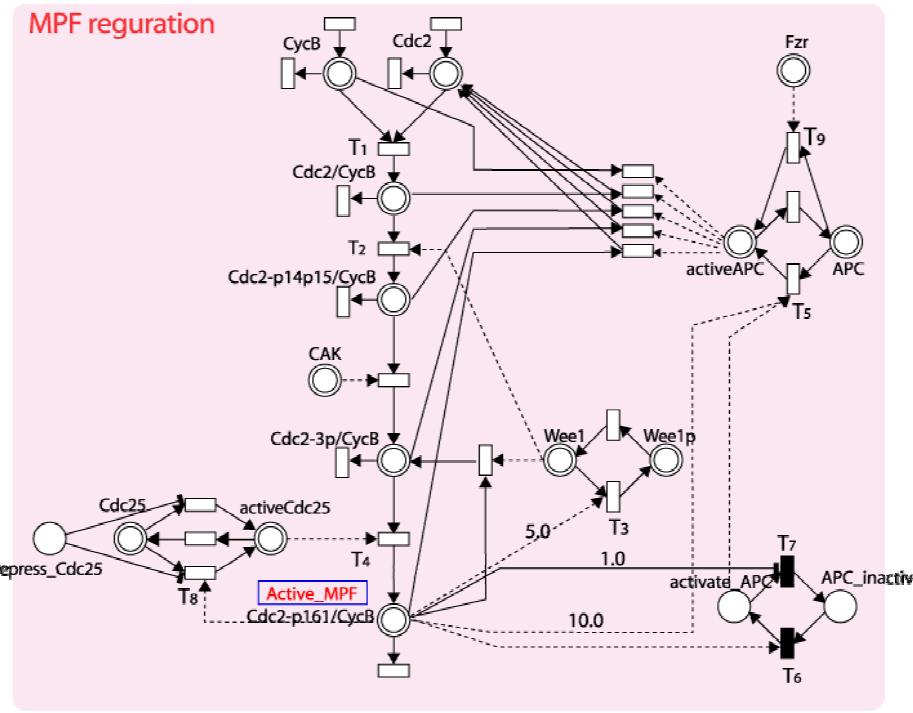
Figure 1. An HFPN model for MPF regulation. In the MPF regulation, four complex types of proteins Cdc2 and CycB play essential roles, which are characterized by the phosphorylation patterns for the three sites Thr-14, Tyr-15, and Thr-161. The places (1) Cdc2/CycB , (2) Cdc2- p14p15/CycB , (3) Cdc2-3p/CycB , and (4) Cdc2-p161/CycB correspond to the four complex types of proteins Cdc2 and CycB: (1) no phosphorylation, (2) Thr-14 and Tyr-15 are phosphorylated, (3) Thr-161 is phosphorylated, and (4) all of three sites are phosphorylated,